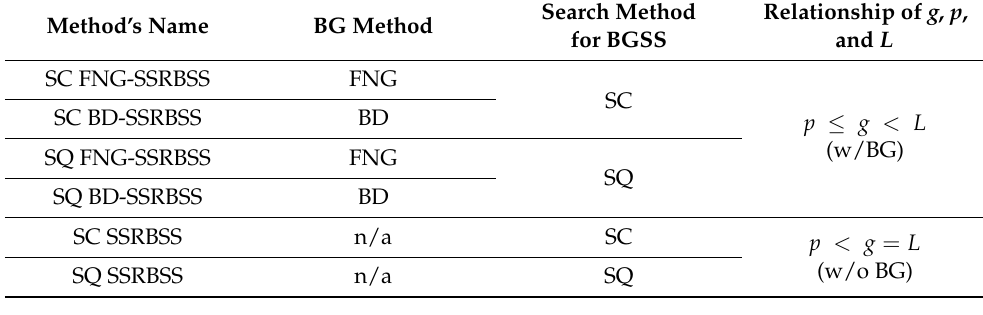
Table 1. The names and definition of six BG-SSRBSS methods.